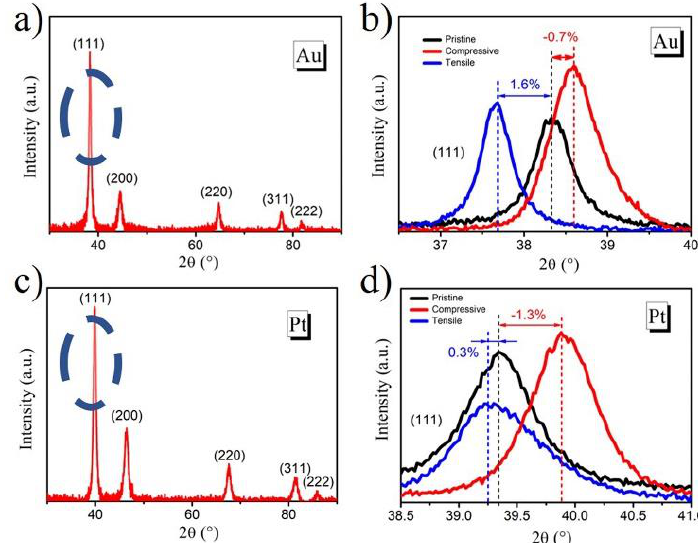
Figure 2. The X-ray diffractometer (XRD) patterns of the as-sputtered Au ( a ) and Pt ( c ) film electrodes. The (111) crystal dominant planes of Au ( b ) and Pt ( d ) electrodes under different strain states. According to Bragg’s equation, the diffration angle can be used to calculate the d-spacing value: 2d sin θ = 𝑛𝜆 .